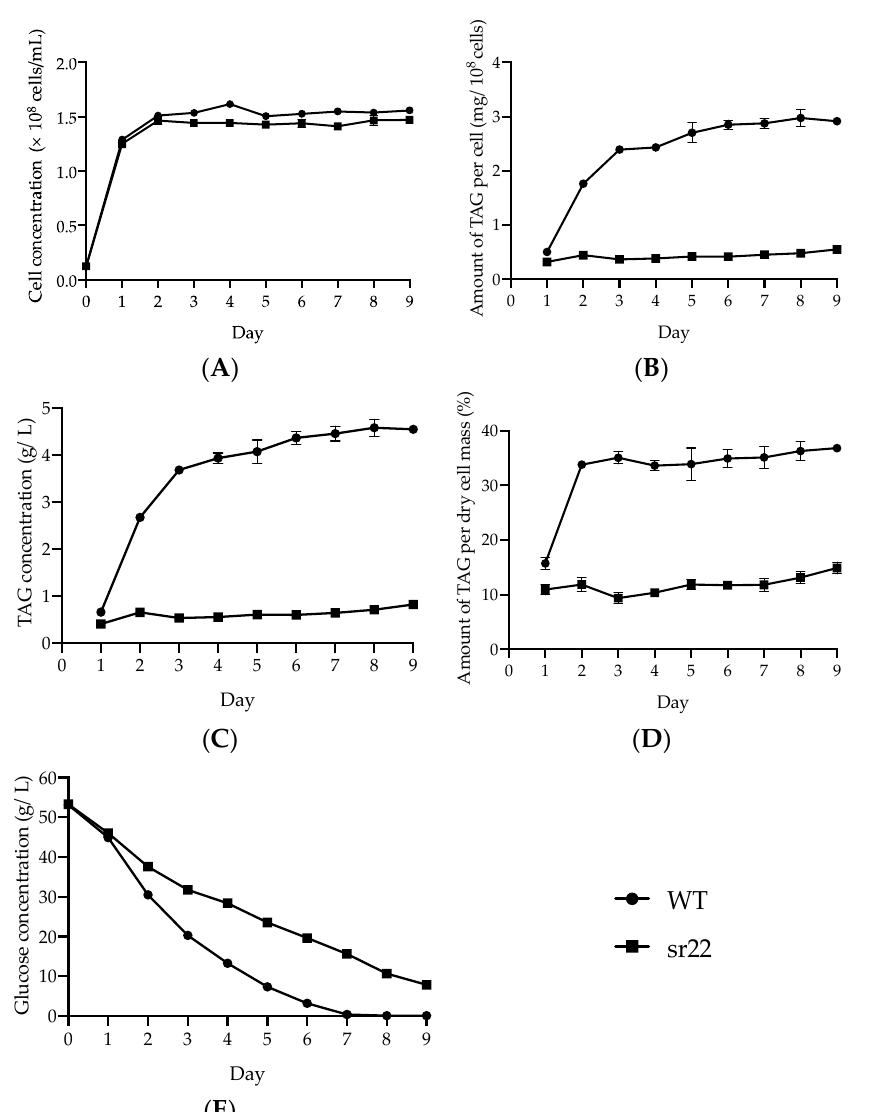
Figure 2. Characterization of the wild-type (WT) and mutant strain sr22. The WT and sr22 cells were cultured on an S medium at 30 °C for nine days in a large-scale culture. Symbols: closed circles, WT; closed squares, sr22. ( A ) Cell concentration (cells/mL), ( B ) amount of TAG per cell (mg/10 8 cells), ( C ) TAG concentration (g/L), ( D ) amount of TAG per dry cell mass (%), and ( E ) glucose concentration (g/L). The data are indicated as the mean ± SEM of the three independent experiments.